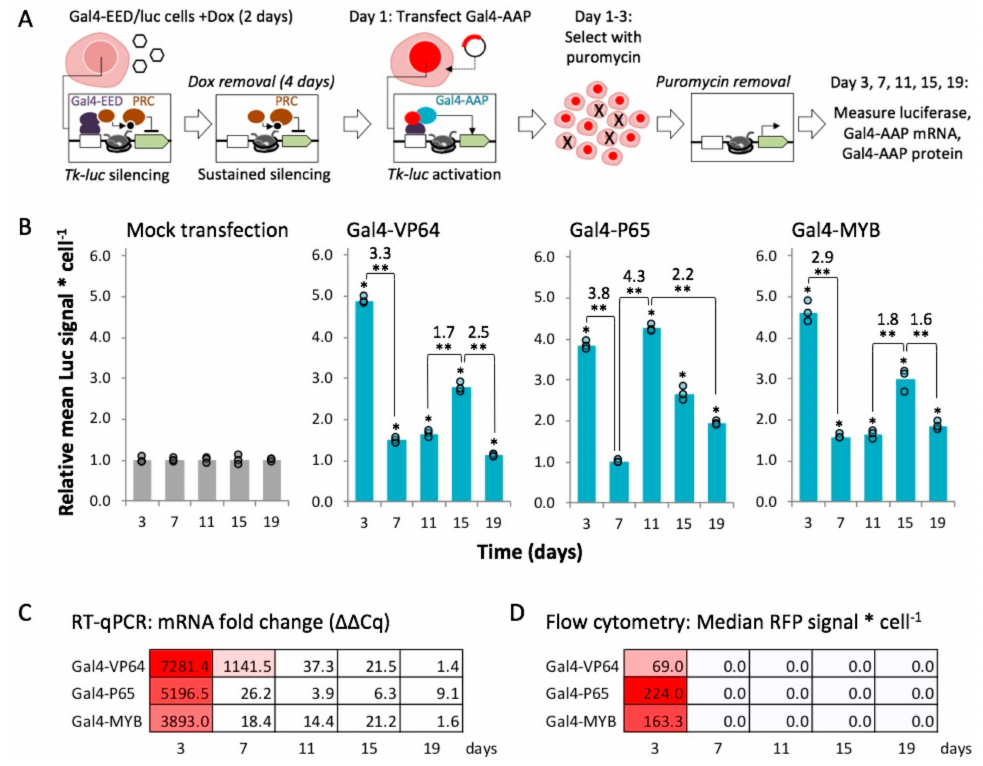
Figure 3. Expression of Polycomb-repressed Tk-luciferase over time after expression and loss of Gal4-P65, Gal4-VP64, or